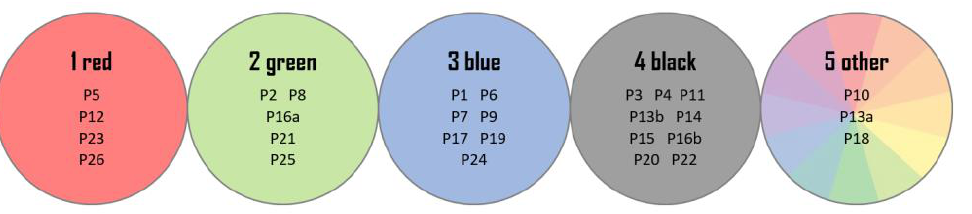
Figure 5. Electropherograms registered for samples B1 – B3, and X at 220 nm, d red — red dyes, d yellow — yellow dyes, d blue — blue dyes.